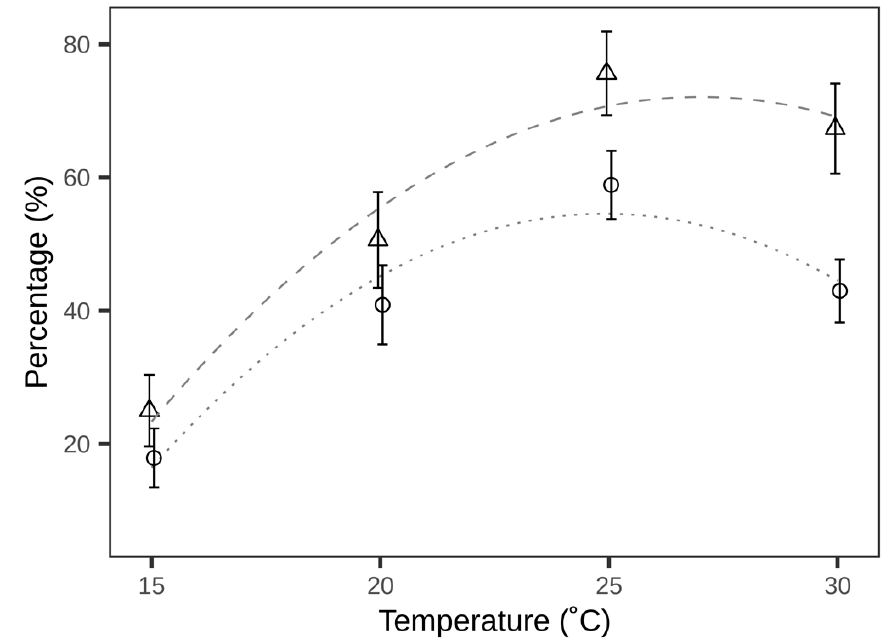
Figure 1. Percentage of leaves with parasitised eggs per plant (means ± standard error of the mean (SEM); triangles; dashed fitted line) and parasitisation efficiency (percentage of parasitised eggs) (means ± SEM; circles and dotted fitted line) at four constant temperatures. Fitted lines are predicted values according to second order polynomial linear models.